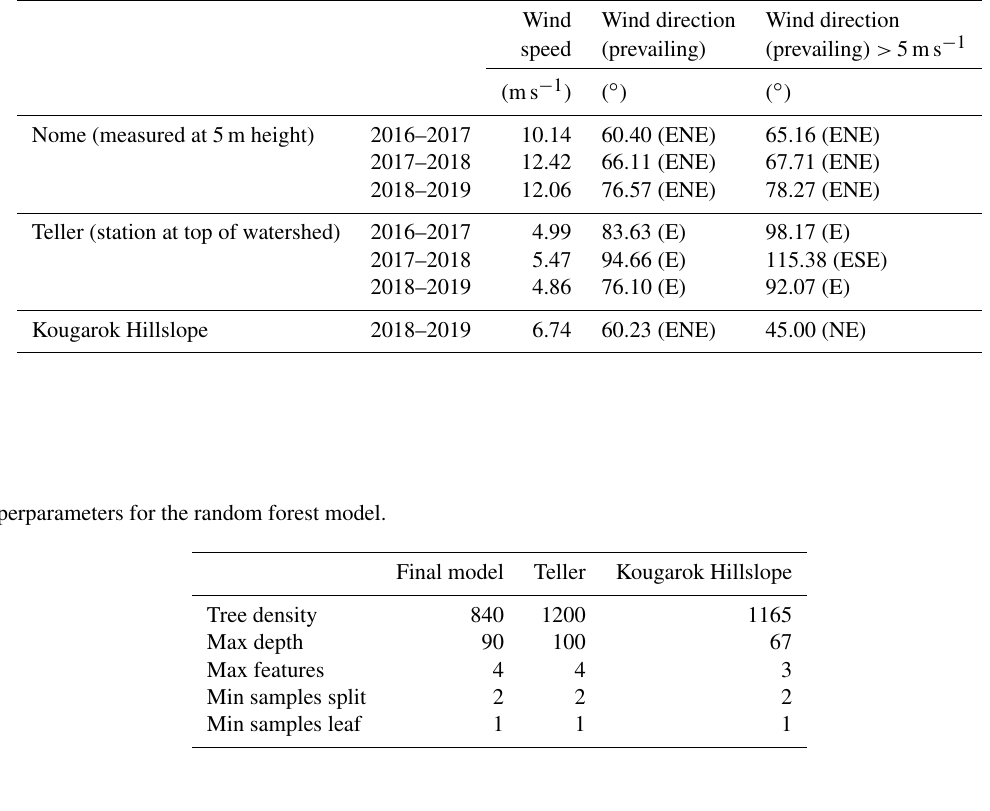
Table A2. Average winter (October–March) wind speed and prevailing direction.